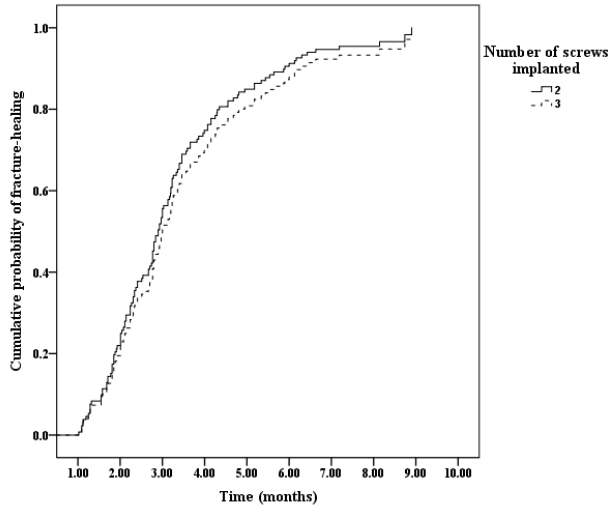
Figure 5. Cumulative probability of achieving radiological fracture healing according to the number of screws